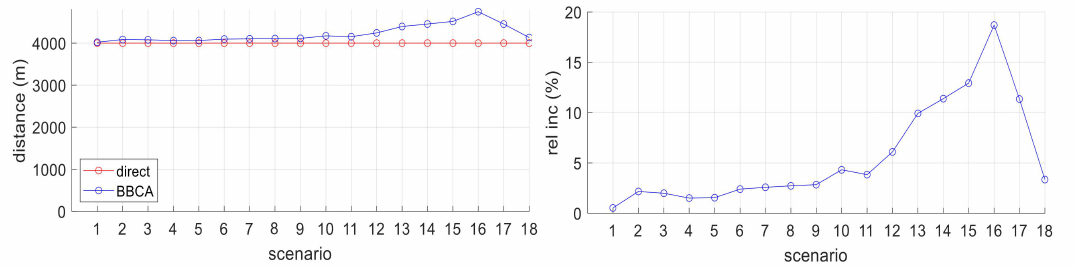
Figure 12. Two-UAV study: distance covered; absolute values (left) and relative increment